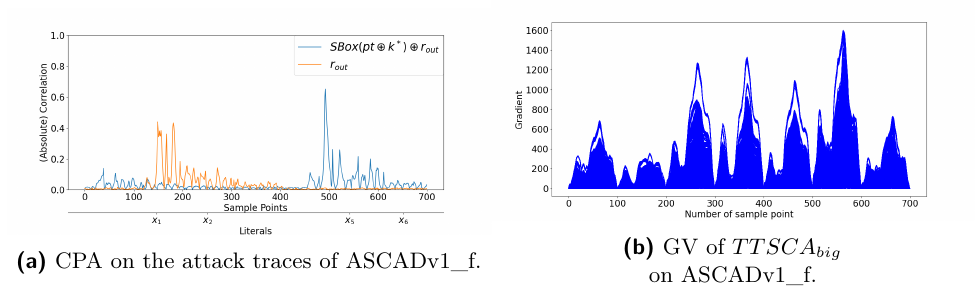
Figure 13: CPA of ASCADv1_f and GV of TTSCA big